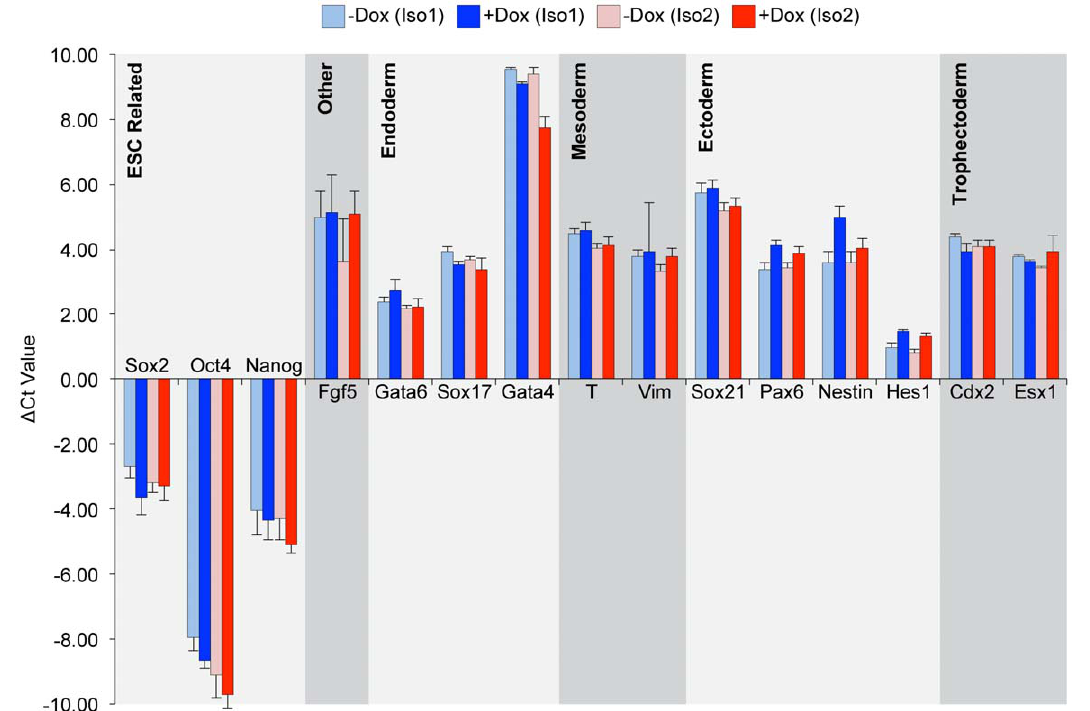
Figure 7. Effects of Msi2 overexpression on the differentiation of ESC. i-Msi2.1-D3 and i-Msi2.2-D3 were treated with or without 1 m g/ml Dox for 48 hours prior to plating at 4,500 cells/cm 2 . Cells were treated with and without Dox in the presence of 5 m M RA for 48 hours, followed by the removal of LIF for 48 hours to further the differentiation of the cells. RNA was isolated from these cells and the expression of a subset of differentially expressed genes was verified by RT-qPCR, as described in the Materials and Methods. Threshold cycle (Ct) values were normalized to GAPDH and represent the difference in transcript levels between the indicated treatment condition and undifferentiatied ESC. A positive Ct value indicates an increase in the level of the transcript in the differentiated cells, as indicated. Multiple rounds of RT-qPCR were used to calculate an average change in Ct value, and error bars represent standard deviation.